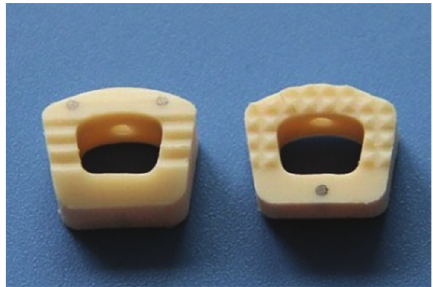
Figure 3: The n-HA/PA66